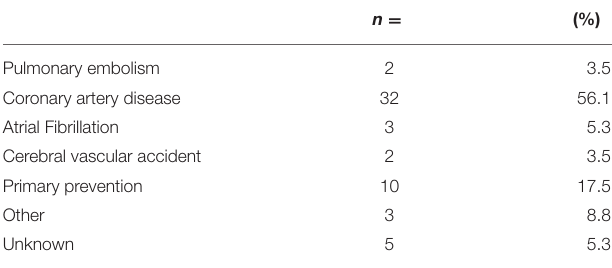
TABLE 3 | Patient comorbidities requiring use of anticoagulant or